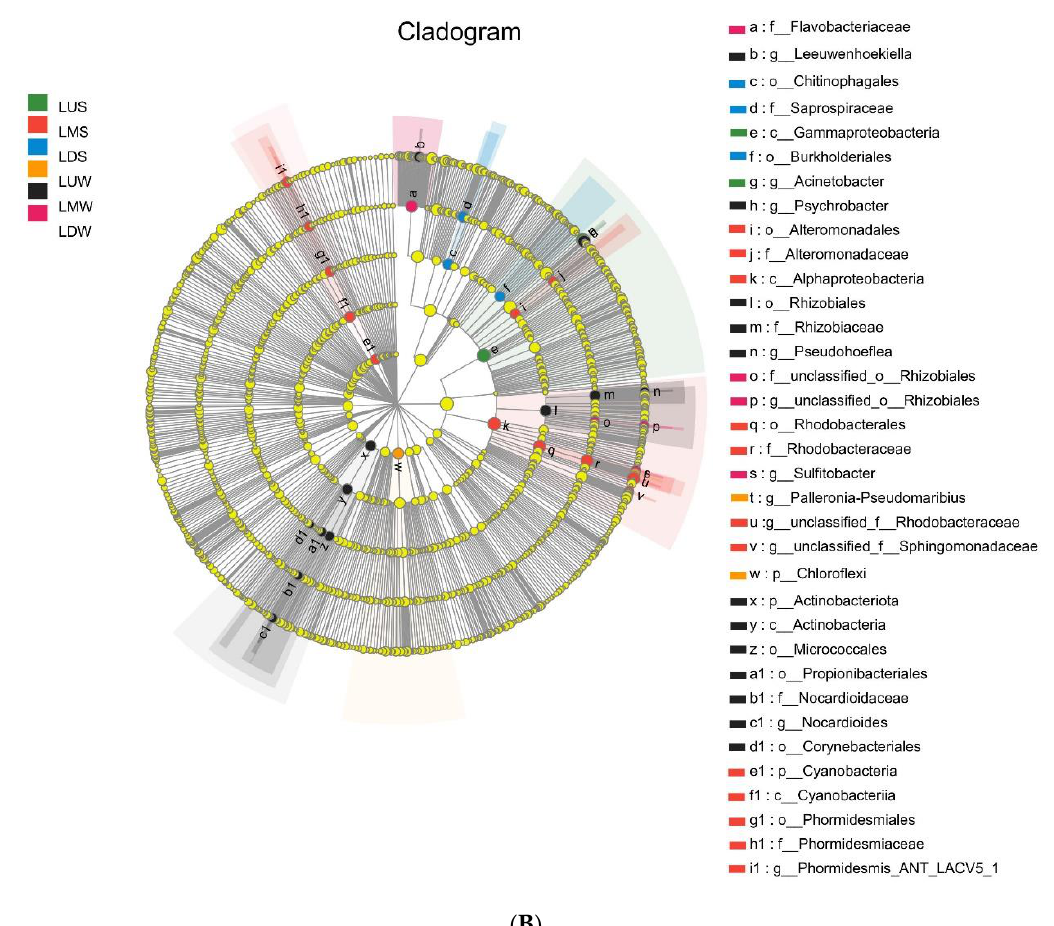
Figure 5. ( A ), Linear discriminate analysis (LDA) was used to compare differences between six groups (LDA score > 4). ( B ), LEfSe analysis was used to show species characteristics that explain differences among multiple groups. Different colour nodes indicate the microbial groups that are significantly enriched in the corresponding groups and have a significant impact on the differences between groups. The yellow nodes indicate the microbial groups that were not significantly different in different groups or had no significant effect on the differences between groups. LUS: summer samples of upper leaves; LMS: summer samples of middle leaves; LDS: summer samples of lower leaves; LUW: winter samples of upper leaves; LMW: winter samples of middle leaves; LDW: winter samples of lower leaves.